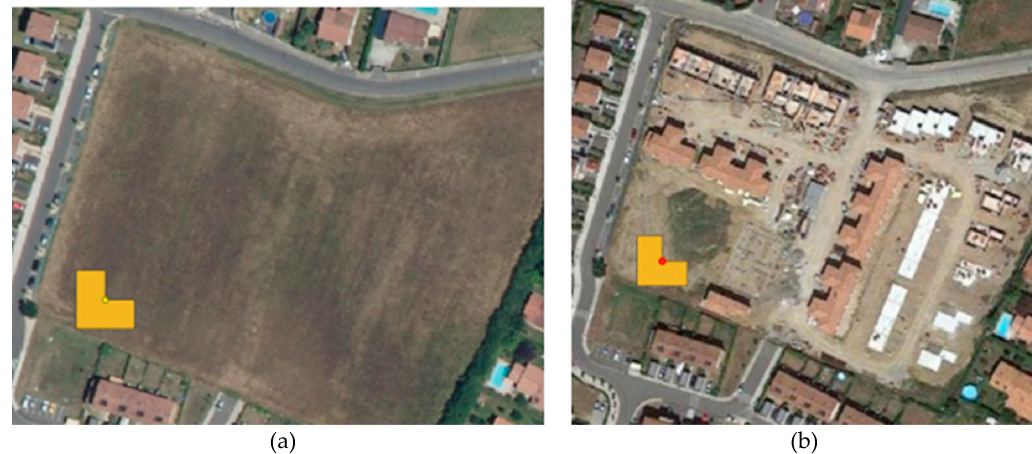
Figure 13: Example showing a change detected as residential by the CDS and considered as No change in the reference overlaid on an orthophoto for ( a ) 2016–Geoportal©IGN and ( b ) 2019-Geoportal©IGN.